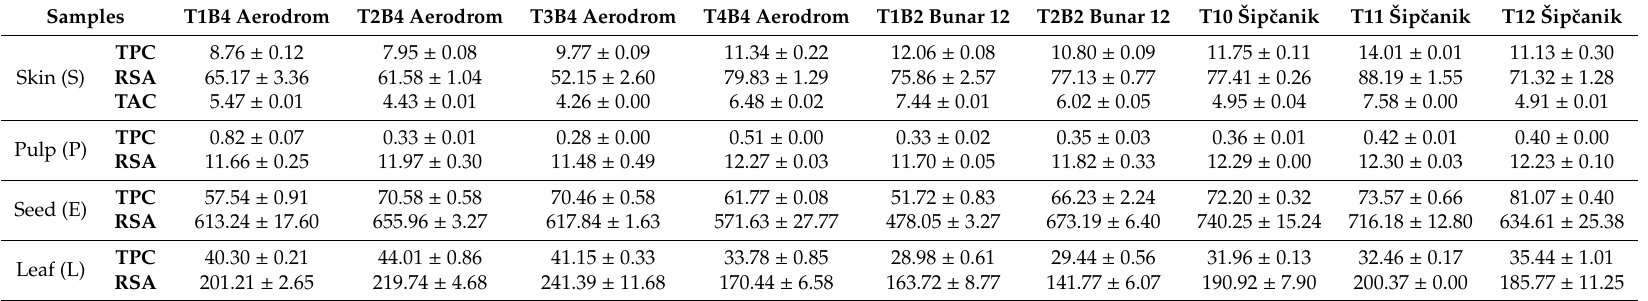
Table 1. Total phenolic contents (TPC, g GAE / kg) and radical scavenging activities (RSA, mmol TE / kg) in the skins, seeds, pulps, and leaves of grapevine samples. Total anthocyanin content (TAC, g mal 3-glu / kg) in grape skins.